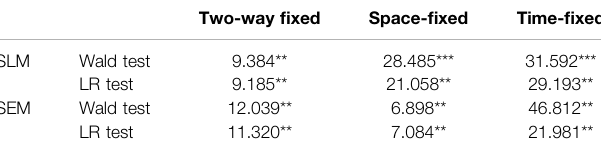
TABLE 3 | Wald test and LR test.